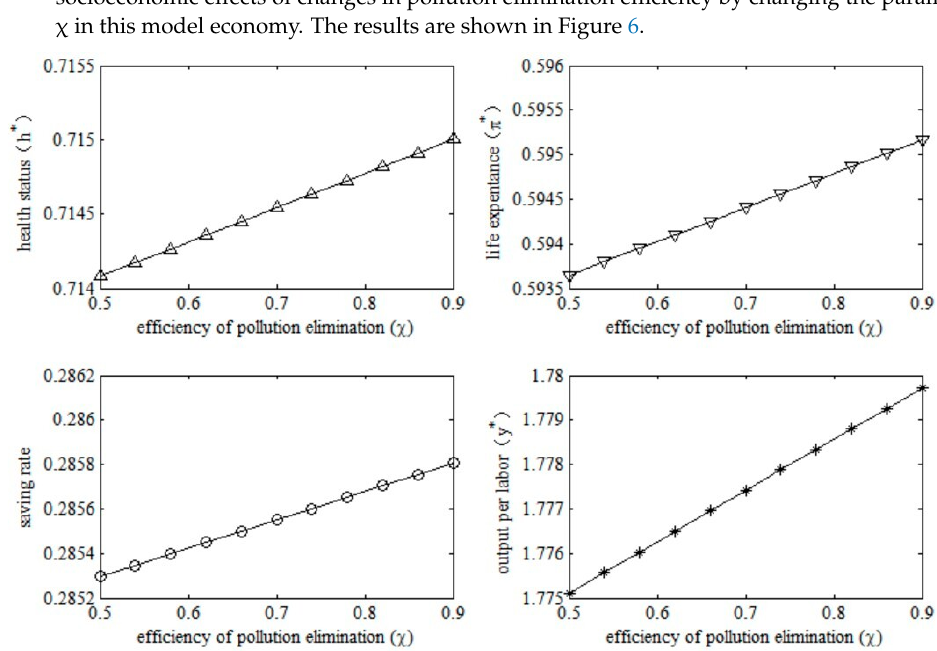
Figure 6. Socioeconomic effects of pollution elimination efficiency.